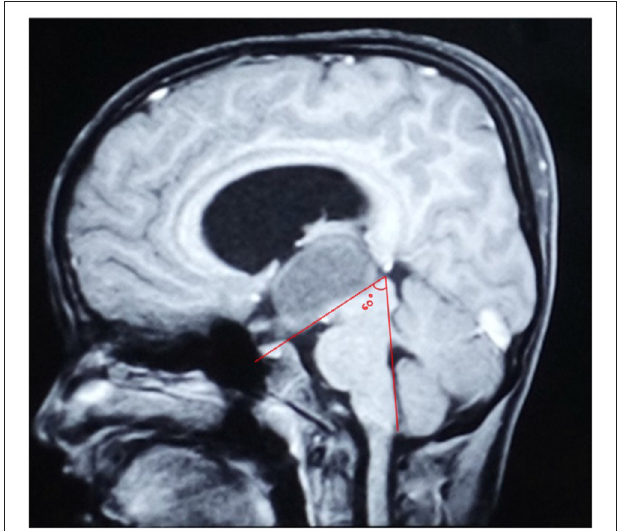
FIGURE 7 | Mid-sagittal MRI image of an 8-year-old boy with a purely intraventricular craniopharyngioma showing the Mamillary Body Angle being 60